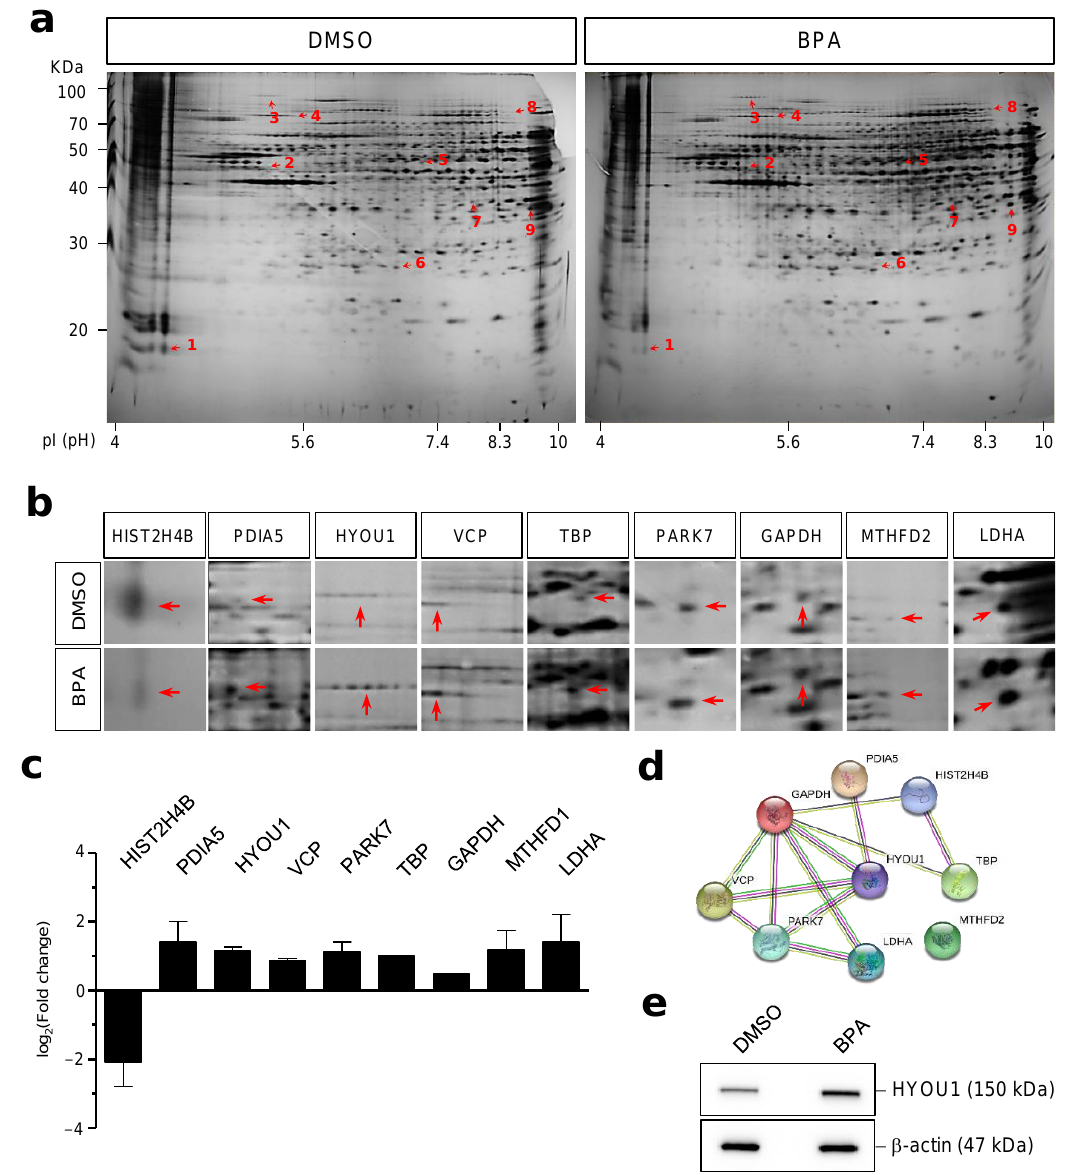
Figure 5. Comparative proteome analysis by low-dose of BPA in Y79 cells. ( A ) Representative silver staining images of 2D electrophoresis patterns from BPA-treated and control groups in Y79 cells. Each spots indicate differentially expressed proteins (red arrow), up- and downregulated proteins, respectively. HIST2H4B (1), PDIA5 (2), HYOU1 (3), VCP (4), PARK7 (5), TBP (6), GAPDH (7), MTHFD2 (8), LDHA (9). ( B ) The nine proteins identified that significant up- and downregulated by exposure to BPA. ( C ) Selected proteins are represented as fold changes (log 2 ). ( D ) The protein network was identified using the STRING database. Network nodes represent proteins shown by gene names and colored lines represent protein–protein interactions. ( E ) Western blot analysis of HYOU1. β-actin was used as a protein loading control.